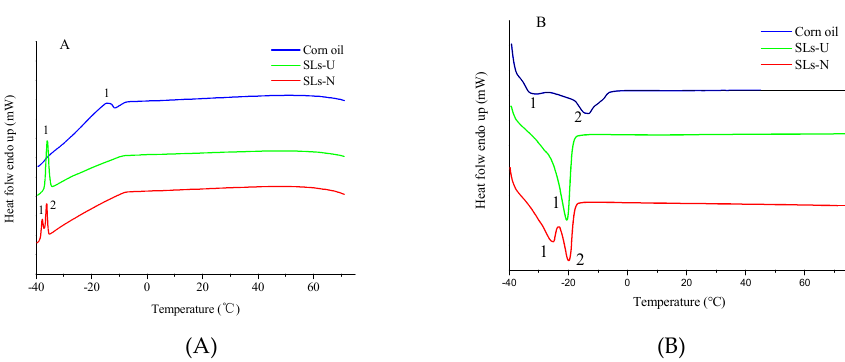
Figure 5. Differential scanning calorimetry (DSC) crystallization curves and melting curves ofcorn oil, SLs-U, and SLs-N ( A , crystallization curves; B , melting curves).